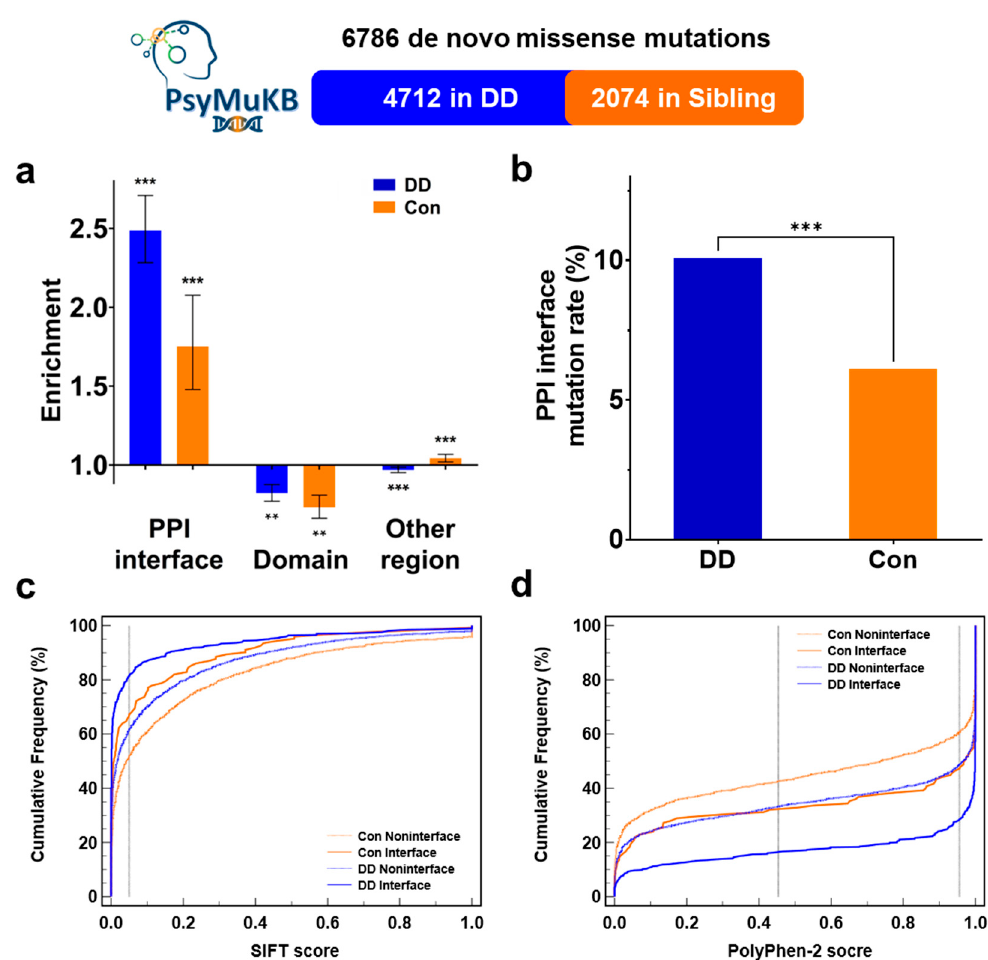
Figure 1. PPI interface DNMs enrichment and deleteriousness in DD. ( a ) Distribution of DNMs from the PsyMuKB across different protein locations. Enrichment was calculated as the ratio of the mutation rate of DNMs at the protein-protein interaction interface over the possibility of interface residues on corresponding proteins. p -Values were calculated using a two-tailed exact binomial test (** p < 0.01; *** p < 0.001). The error bars indicate standard error. ( b ) Mutations rate of DNM missenses at protein-protein interaction interface between developmental delay and sibling controls from the PsyMuKB. p -Values were calculated by a two-tailed Fisher’s test. ( c , d ) Cumulative frequencies of SIFT ( c ) and PolyPhen-2 ( d ) scores for protein-protein interface mutations.